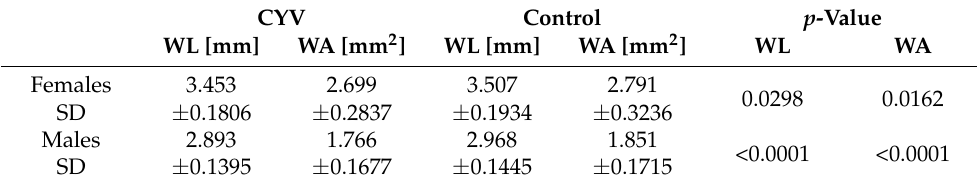
Table 3. CYV induced alteration in the morphological trait wing size. Change in wing length (WL) and wing area (WA) with SD was defined by determining the difference for both traits between the offspring of CYV-injected females and the offspring of medium-injected females. All p -values are based on the Mann–Whitney test for nonparametric data. Sample size: CYV female: n = 295, CYV male: n = 286, control female: n = 102, and control male: n =